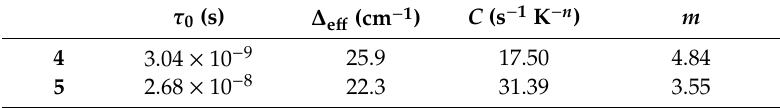
Figure 6. Comparison of the temperature-dependent relaxation under an applied dc field of 0.1 T for 4 (green) and 5 (blue). The solid black lines represent fits to the experimental data using the appropriate magnetic relaxation pathways (Equation (3)). Table 5. Summary of temperature-dependent ac magnetic data for 4 and 5 .